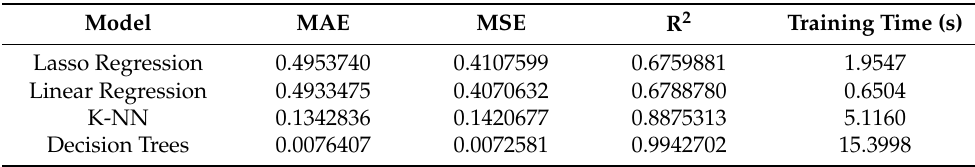
Table 3. Performance measurement in different